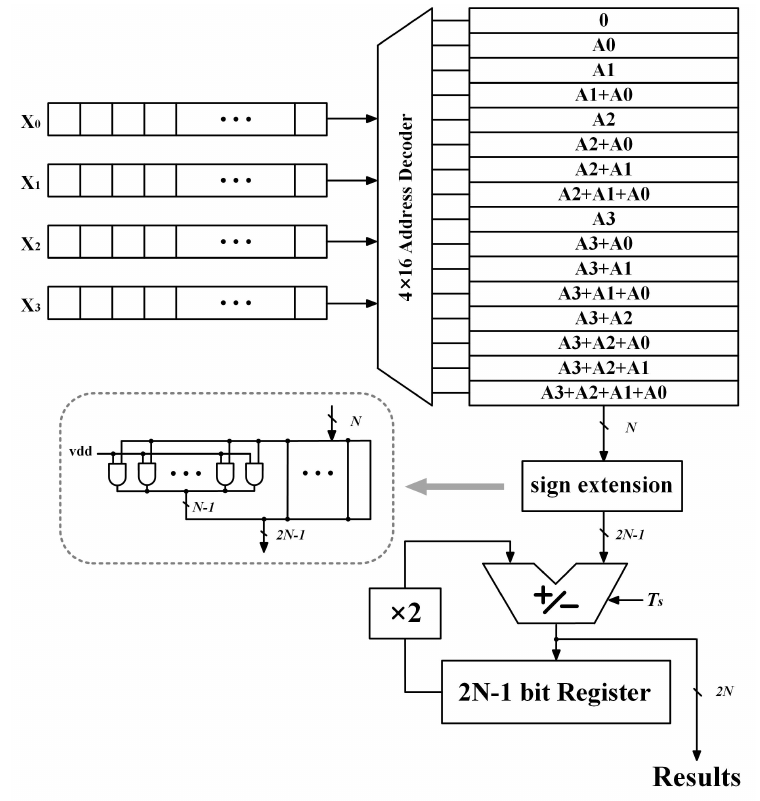
Figure 1. Conventional most significant bit (MSB)-first distributed arithmetic ROM and accumulator (RAC)